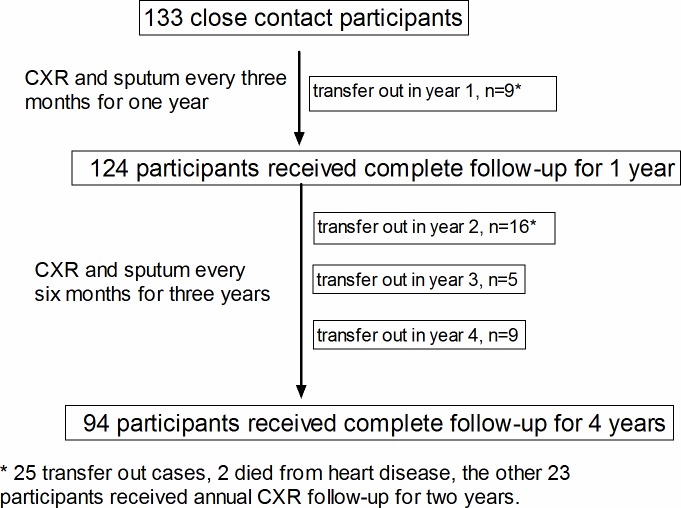
Flow chart of enrollment of participants.